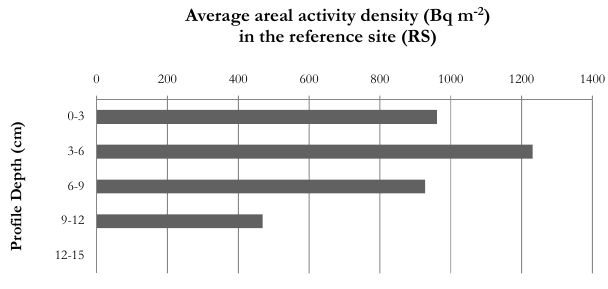
Fig. 5. Mean depth distribution of 137 Cs (Bqm − 2 ) in the soil of the upper deposition area (UDA).